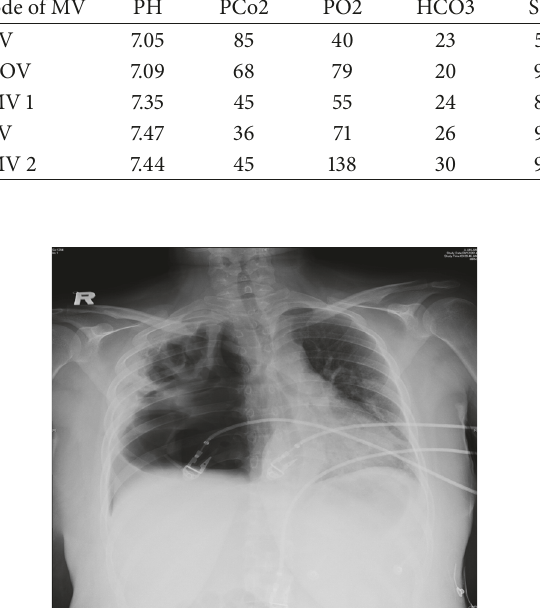
Figure 1: Chest X-ray showing right upper lobe cavitary lesion with a large pneumothorax and pleural